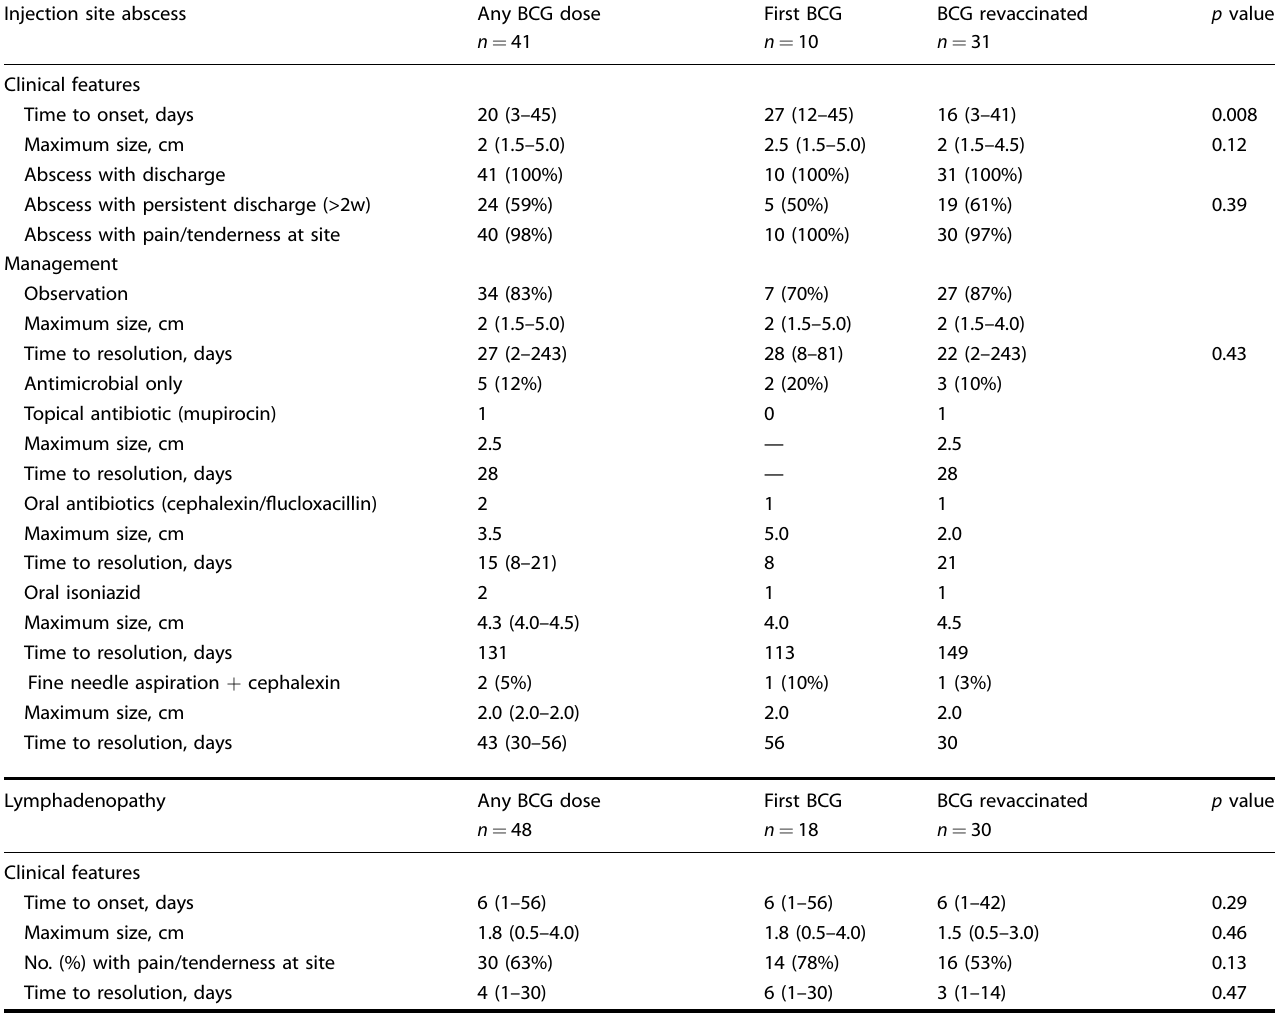
Table 2. Clinical features of BCG local adverse